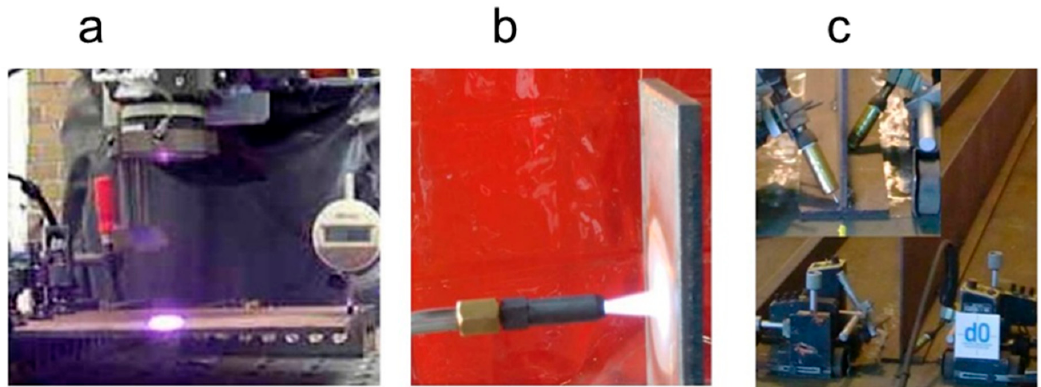
Figure 2. Experimental procedures, ( a ) heatline laser forming process; ( b ) propane heating process; ( c ) flux cored arc welding (FCAW) welding